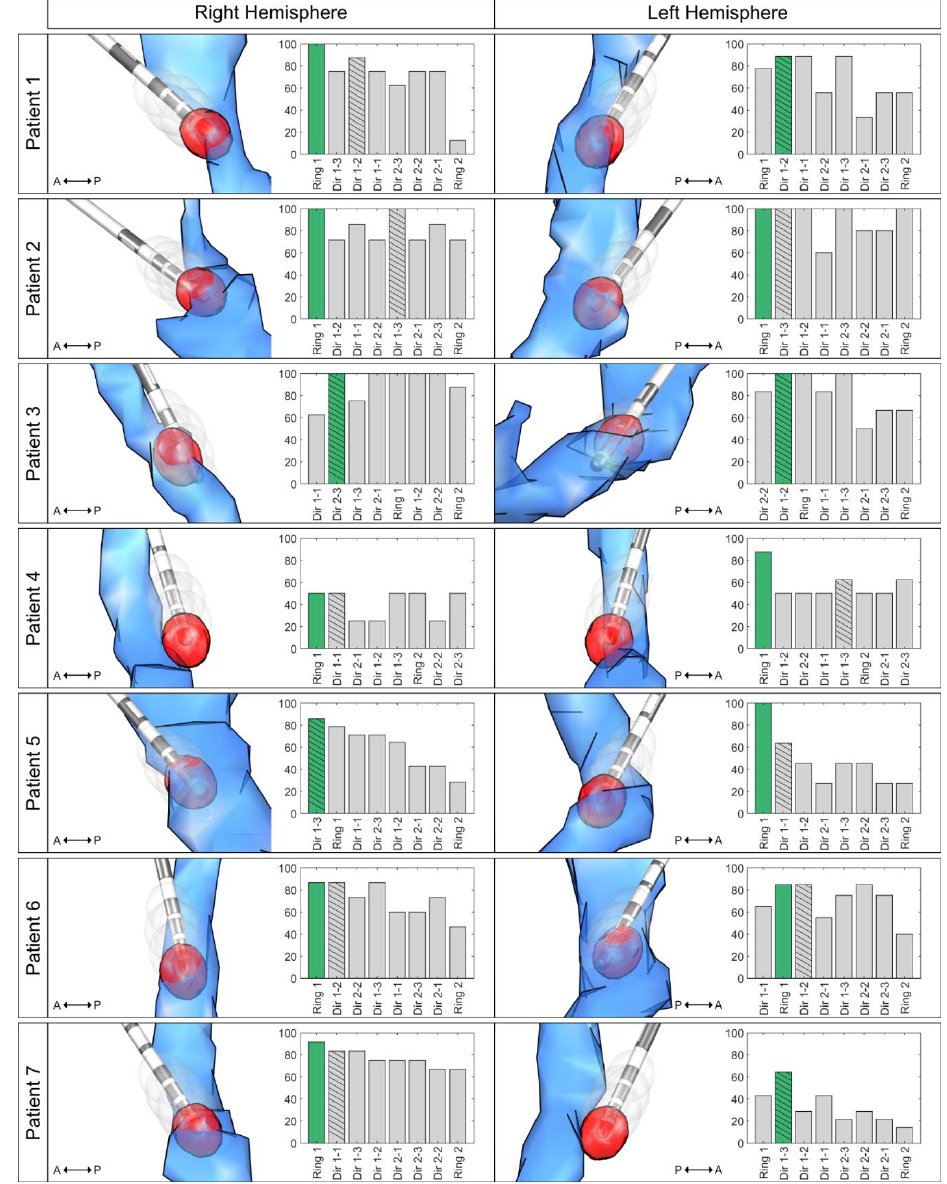
Figure 1. (corrected) – Contact Ranking. Bar plots illustrate the ranking of the overlap, with the individual dentatorubrothalamic tract (DRTT) per contact on the x axis (highest overlap to lowest overlap) and the improvement in tremor control in % on the y axis. The most effective contact is marked in green (with the highest overlap in case more than one contact had the best improvement), and the bar of the most effective directional contact is hatched. The respective left column illustrates the relation between the generated volumes of tissue activated (VTAs, gray) and the DRTT (blue) and the respective lead in the medial view. The VTA with the highest DRTT overlap is highlighted in red. For illustration, only the 10% highest values of the track probability map are shown. Abbreviations: A = anterior; DRTT = dentatorubrothalamic tract; P = posterior; VTA = volume of tissue activated; Dir 1 = ventral directional level; Dir 2 = dorsal directional